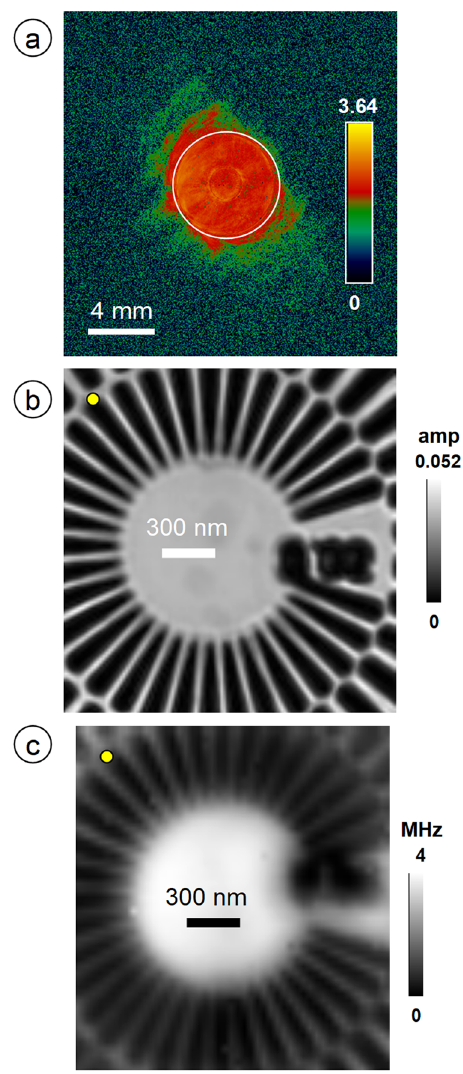
Fig. 1 Ptychographic imaging of a Siemens star test pattern. a Diffraction pattern from a focused, 62 nm diameter spot of 285.2 eV soft X-rays hitting the edge of an Au line of the Siemens Star pattern. The false-color scale is log 10 of the X-ray counts averaged over 100 images, each recorded with 500 ms exposure time. The scale bar is the camera dimension. The white circle in ( a ) is the outer edge of the annulus of the projected beam through the Fresnel zone plate. The corners of the image correspond to a momentum of 0.0104 nm − 1 . b Amplitude image of the 50 nm half-pitch Siemens Star pattern from the reconstruction of a (50 × 50) array of ptychographic images (see Supplementary Table 1 for details of the acquisition and reconstruction parameters). c STXM transmission image measured simultaneously with the ptychography data of ( a ) and ( b ). The yellow circles in ( b ) and ( c ) indicate the location of the X-ray beam when the diffraction pattern in ( a ) was